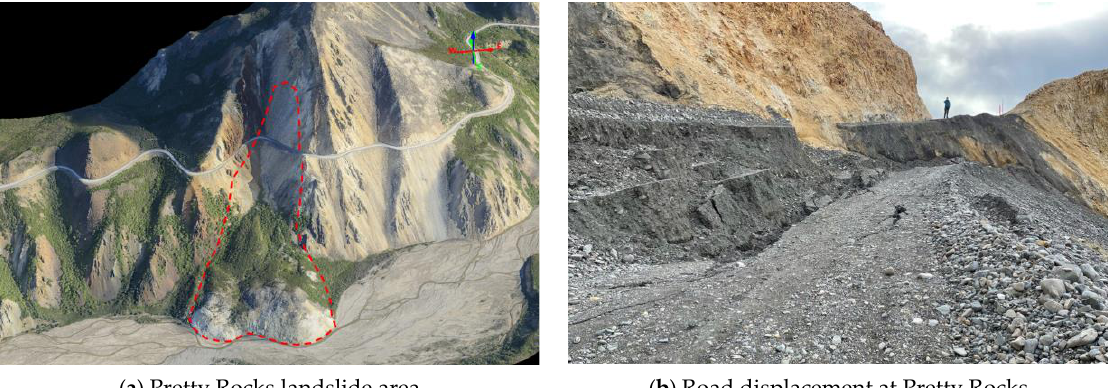
Figure 1. ( a ) Outline of the Pretty Rocks landslide along the Denali Park Road in 2015 (red dashed lines), and ( b ) road displacement of 14 vertical feet in the slide area in 2021 (Source: National Park Service photos; https://www.nps.gov/dena/learn/nature/pretty-rocks.htm, accessed on 29 July 2022).